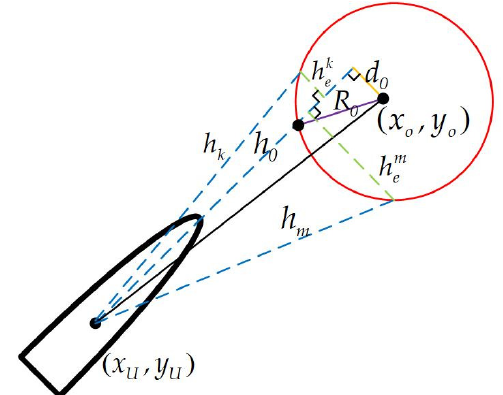
Figure 3. Geometric description of purposed obstacle avoidance